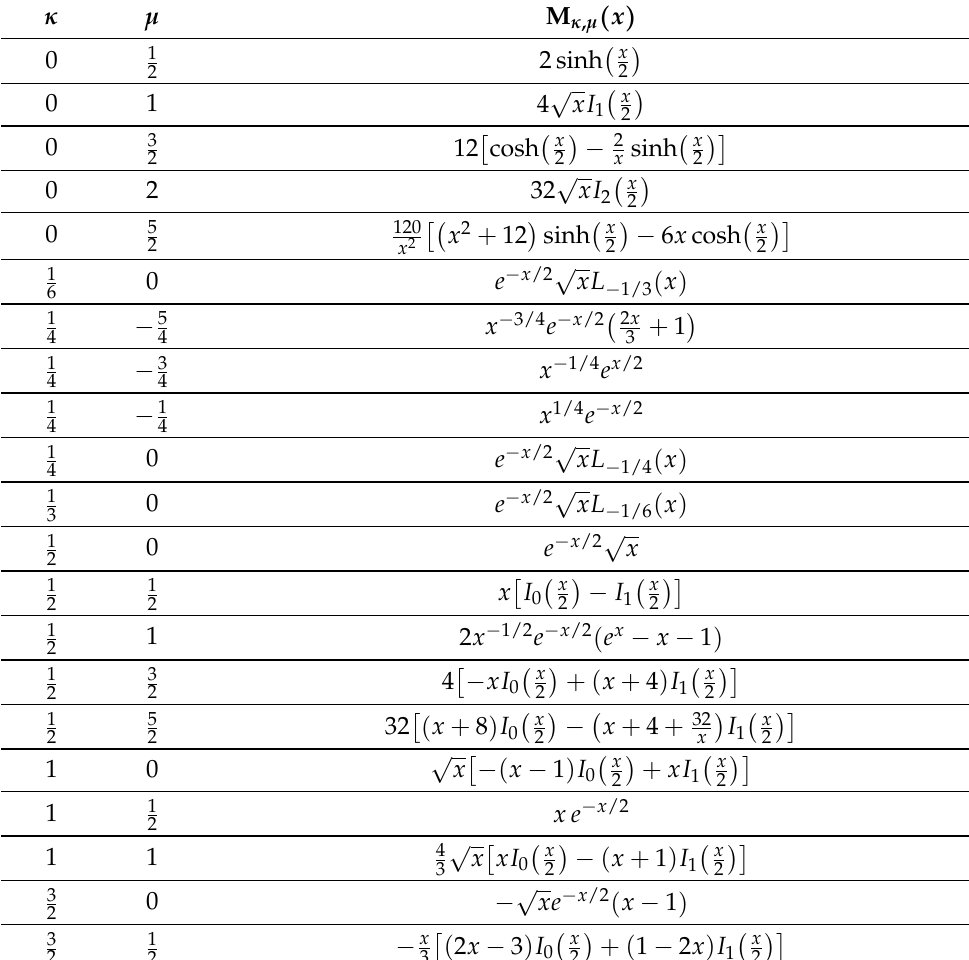
Table A6. The Whittaker functions M κ , µ derived for some values of parameters κ and µ by using